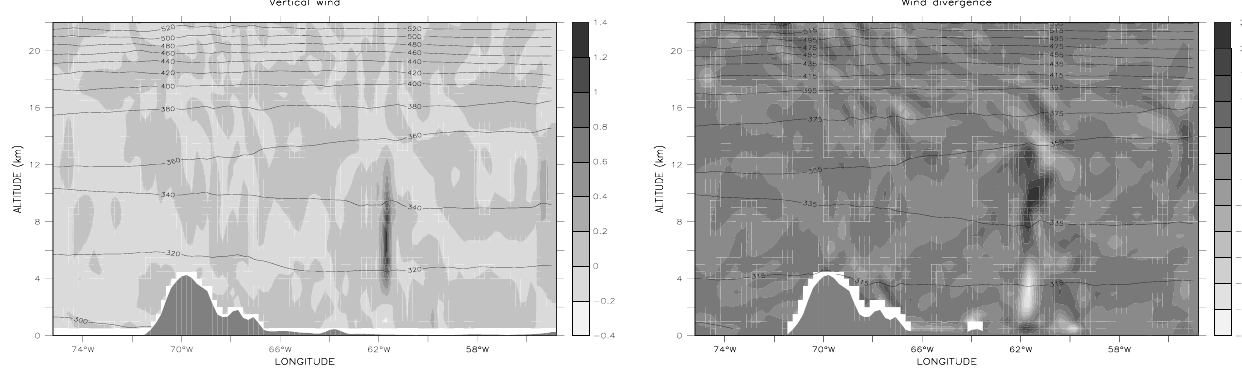
Fig. 14. Case 2: Results of the WRF simulations. Longitude-altitude cross sections at latitude − 29.45N. Left: Vertical wind velocity (ms − 1) and isentropes (K). Right: Horizontal wind divergence (s − 1) and isentropes (K).